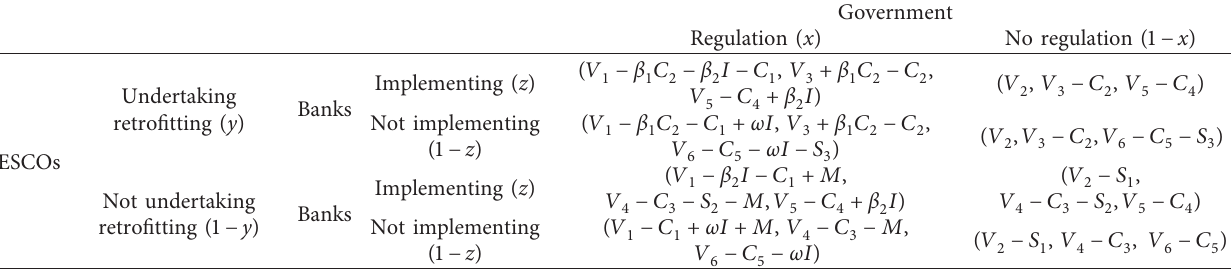
Table 1: Government, ESCOs, and banks perceived payoff matrix.